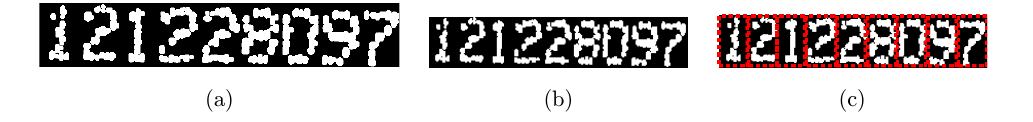
Fig. 11. Comparison between the images before and after normalization. (a) Image before normalization, (b) image after normalization and (c) digits segmentation.